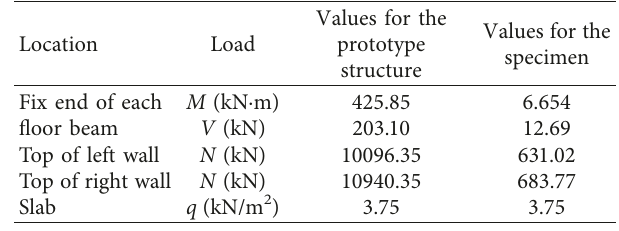
Table 3: Gravity load acting on the specimen. Values for the Location Load prototype